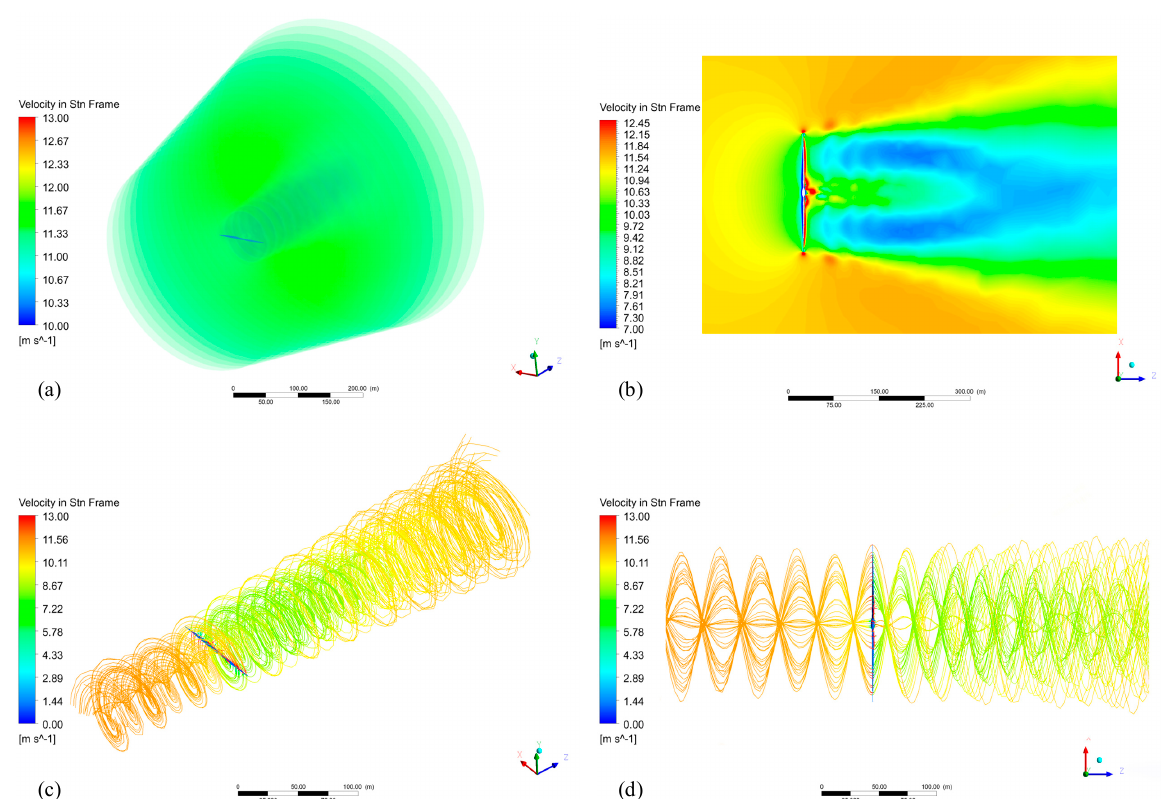
Figure 14. Flow field and streamline of the Two − BWT. ( a ) 3D wind speed cloud map of the whole flow field; ( b ) Wind speed cloud map of the axial section of the whole flow field; ( c ) Streamline distribution maps of the whole flow field; ( d ) Streamline distribution maps of the axial section of the whole flow field.